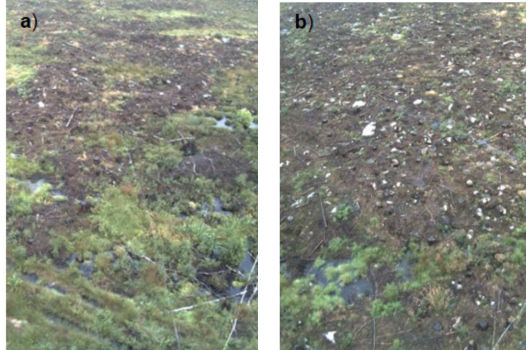
Figure 3. Digital camera images of a part of plot 1 ( a ) and of a part of plot 2 ( b ) taken on the same day in mid-August 2011. The images cover approx. 40 × 60 m of each plot. Large areas with standing water can be seen in the lower half of the image of plot 1. A small area with standing water can be seen in the lower left part of the image of plot 2, but this plot was in general drier than plot 1. The vegetation cover on both plots was dominated by grasses and shrubs, as most evident on plot